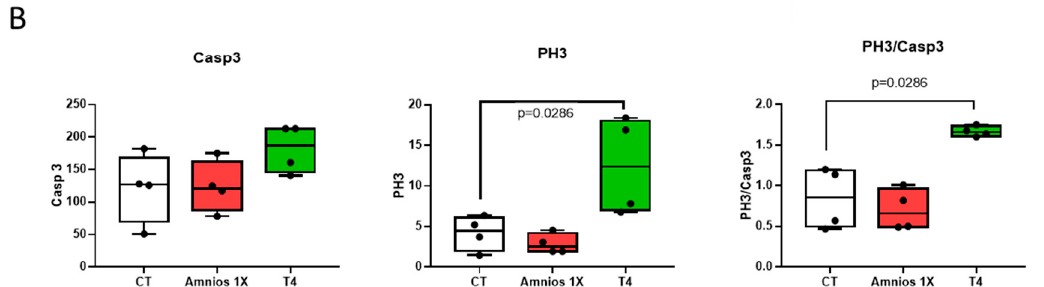
Figure 6. Effect of Amnios 1X and T 4 on proliferation and apoptosis in tadpole brains. For each treatment group, 2 tadpoles from 3 different females were analyzed. ( A ) Example cross-sectional images of brains following immunochemistry: apoptosis marker in red (caspase3), proliferation marker in green (PH3). Scale bar, 100 µm. ( B ) Average number of positive cell nuclei per section for caspase3 and PH3, and the ratio of proliferative/apoptotic cells.